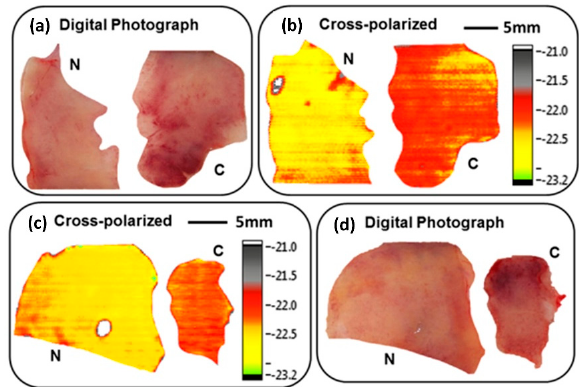
18 of 27 Figure 13. THz solid immersion microscopy of soft biological tissues with the spatial resolution of 0.15 λ : ( a ) Photo of an ex vivo human breast tissue specimen; ( b ) THz SI microscopy image of hu- man breast tissue; ( c ) The diagnosis of the breast tissue specimen as confirmed by histology [54]. Copyright © 2018, AIP Publishing. All rights reserved. 5.1.4. Human Colon Tissues Colon cancer, with the highest incidence in the 40–50 years old age group, is a com- mon malignant tumor of the digestive tract in the colon and often occurs at the junction of the rectum and the sigmoid colon. It is asymptomatic in the early stage, but abdominal distension and indigestion can occur in the middle and late stages [89]. In 2016, Wahaia et al. imaged human dehydrated colon tissue resections embedded in paraffin of 2 mm thick- ness and 0.5 mm spatial resolution, using high-resolution transmissive and reflective im- aging technologies at 590 GHz [90]. The contrast of THz wave absorption between the tumour and normal tissues reached 23%, and the colon cancer tissues had higher absorp- tion and reflectivity, which distinguished cancer tissues from normal tissues. They also used the same system to image fresh samples and reached the same delimitation conclu- sion, which meant that the high water content in THz images could distinguish cancer and normal tissues in both fresh and dry samples. The imaging system could also distin- guish the tumour stages, such as pT3 type (underdeveloped) and pT4 type (slightly de- veloped). Due to the thickness and unevenness of samples, extracting accurate parameters (such as absorption) from the THz images is challenging. In recent years, some optimised CW imaging systems were developed to improve the imaging accuracy, such as THz po- larisation imaging technology. In 2013, Doradla et al. used an optically pumped far-infra- red molecular gas laser to produce the frequency of 584 GHz, the reflective polarisation THz imaging system as shown in Figure 3, and they imaged fresh human colon sections with 4–6 mm thickness by reflective polarisation THz imaging with a 0.6 mm spatial res- olution [41]. The normal and cancerous tissues have a sharp contrast in their absorption